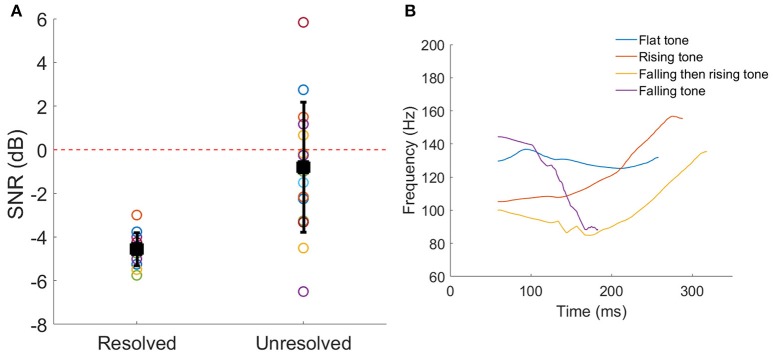
(A) The SNRs corresponding to 79.4% correct Mandarin tones identification for each participant. The black squares represent the mean SNR, and the line bars represent the SD. The red dashed line represents the SNR = 0 dB which was used in the FFR recording. (B) The four F0 contours of a vowel /a/. The color represents the different tone.